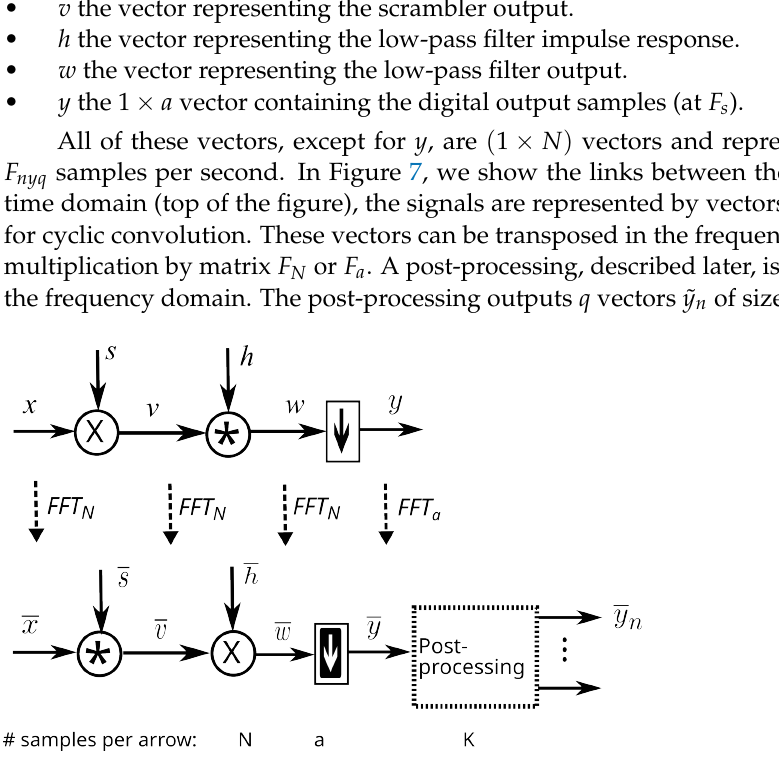
Figure 7. Principle of the system, using vector notations, in the time and frequency